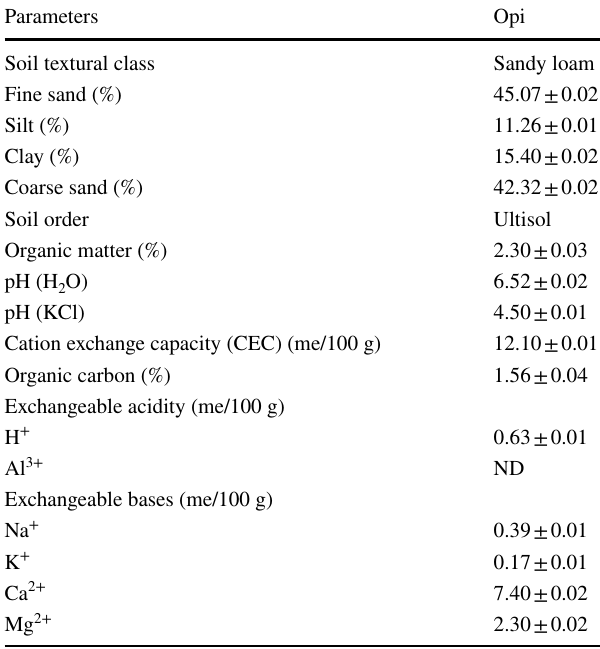
Table 1 Mean physicochemical parameters of studied soil sample